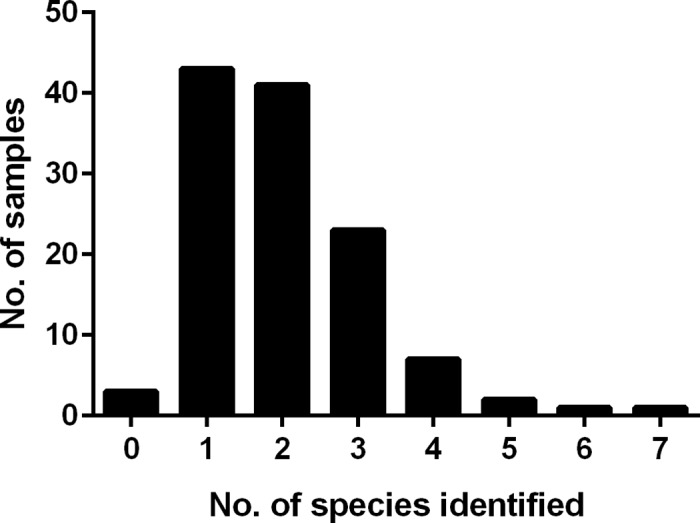
Detection of multiple microorganisms in bronchoalveolar lavage samples by PCR/ESI-MS.A total of 121 bronchoalveolar lavage samples were analyzed. The number of samples is depicted against the number of bacterial and Candida species identified per sample; various α-hemolytic streptococcal species are counted as one species.